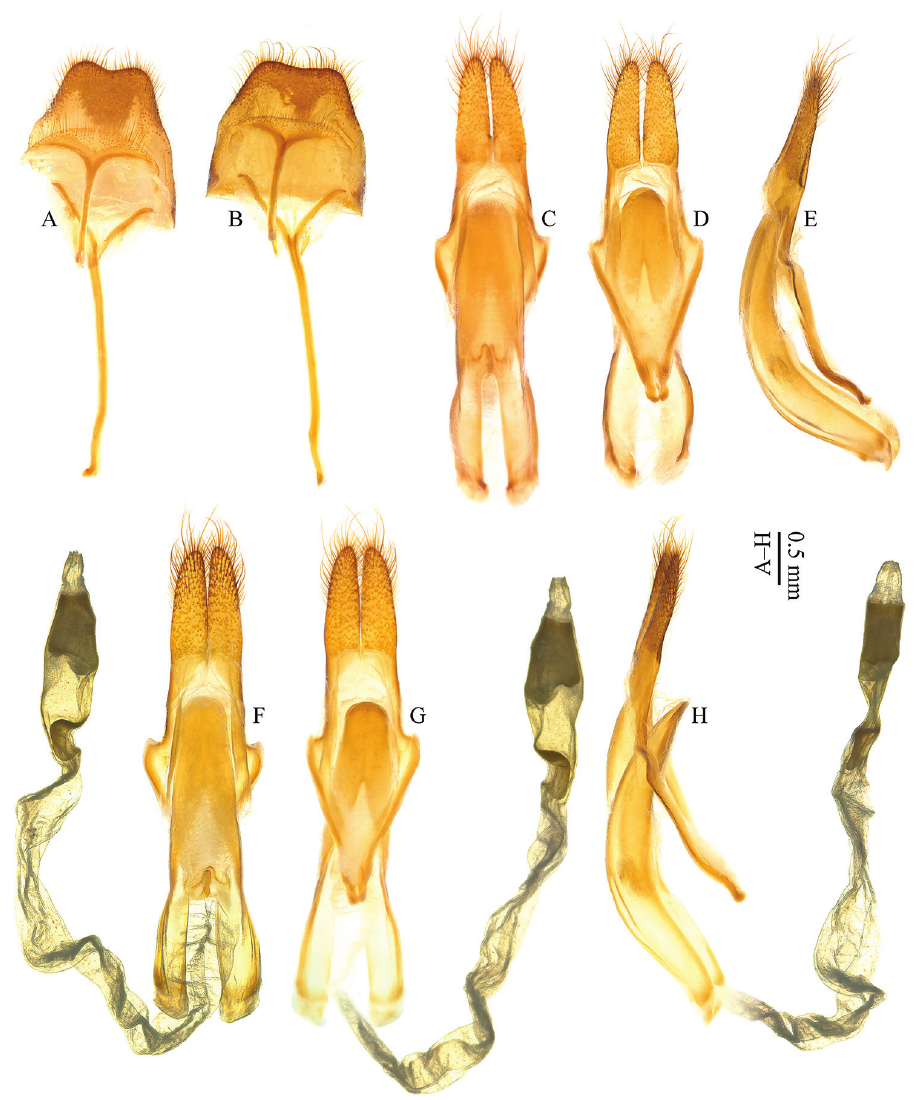
Figure 4. Pseudomacrochenus species. ♂♂ . A, C–E P . antennatus (Gahan, 1894) (Yunnan) B, F–H P . wusuae sp. n. (paratype) A–B tergites VIII, sternites VIII & IX (ventral view) C–H male genitalia ( C, F dorsal view D, G ventral view E, H lateral